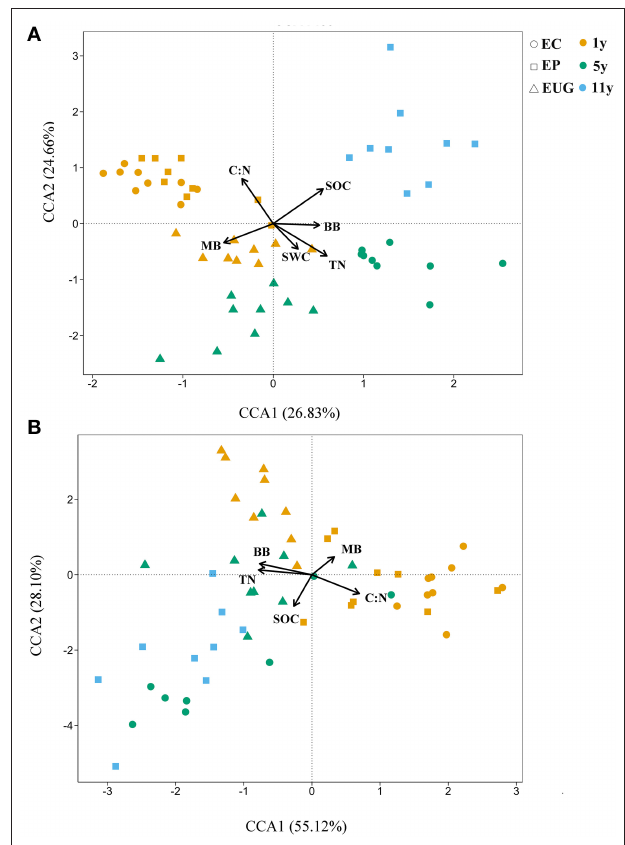
FIGURE 5 | Canonical correspondence analyses (CCAs) showing (A) fungal and (B) functional community structures in Eucalyptus plantations with different ages and species with environmental variables as explanatory factors. EC, E. camaldulensis ; EP, E. pellita ; EUG, E. urophylla × E. grandis ; 1y, 1 year; 5y, 5 years; 11y, 11 years; SOC, soil organic carbon; TN, total nitrogen; C:N ratio, ratio of soil organic carbon to total nitrogen; SWC, soil moisture content; MB, microbial biomass; BB, bacterial